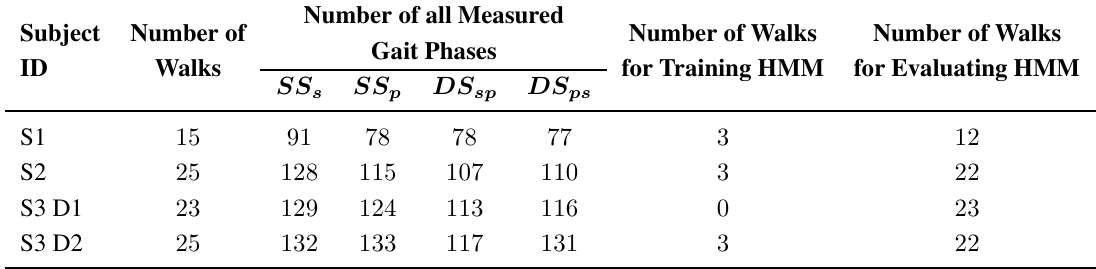
Table 5. Number of walks, acquired gait phases and hidden Markov model (HMM)